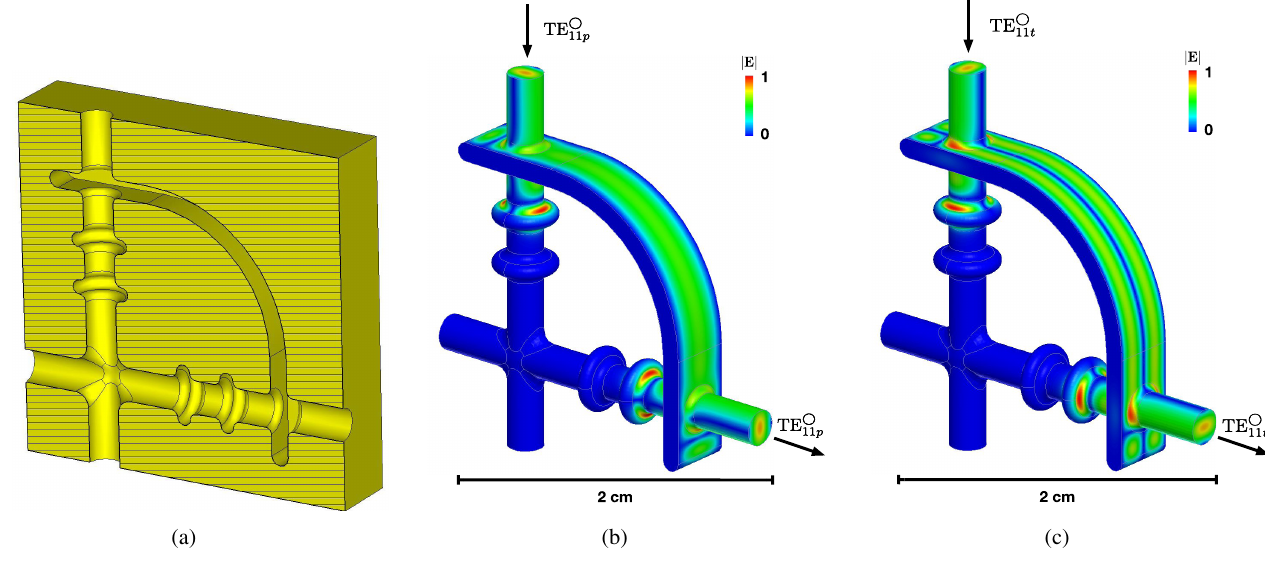
FIG. 26. Dual-moded bend, adapted from Toufexis et al. [23]. (a) Metallic Surface, (b) surface electric field for the parallel polarization, and (c) surface electric field for the transverse